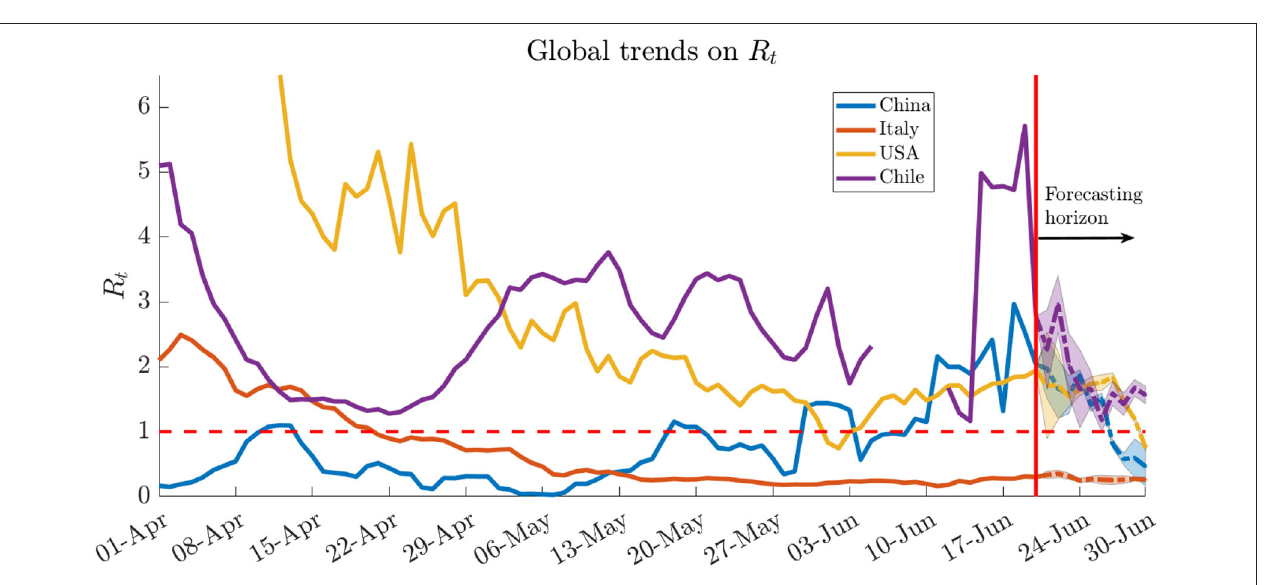
FIGURE 2 | Forecast for the evolution of R t in selected countries. Even though countries, such as Chile and the USA are approaching the control threshold of R t = 1, the immediate forecast is not so optimistic. Details of the different governmental actions taken in the timeline are presented in Table 2 . The Chilean curve is not continuous in the second week of June due to changes in the data-reporting criteria [30].